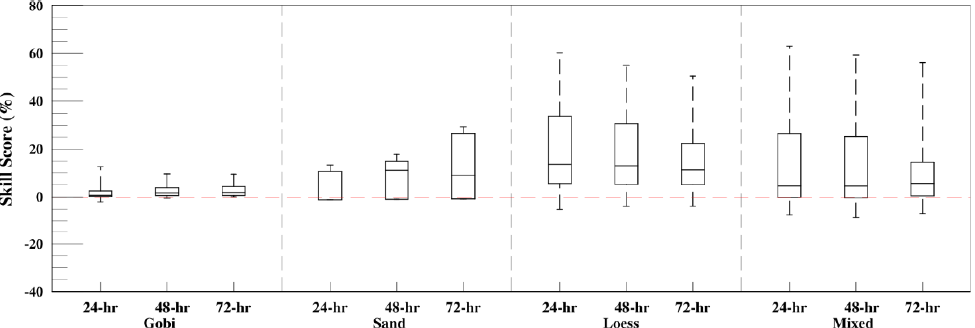
Figure 5. Box-and-whisker plots of the skill scores of the NEW_RF run over the OLD_RF run at the 24 h, 48 h, and 72 h valid times according to soil types. Bars from the top represent 100%, 75%, 50%, 25%, and 0% of the total data, respectively.